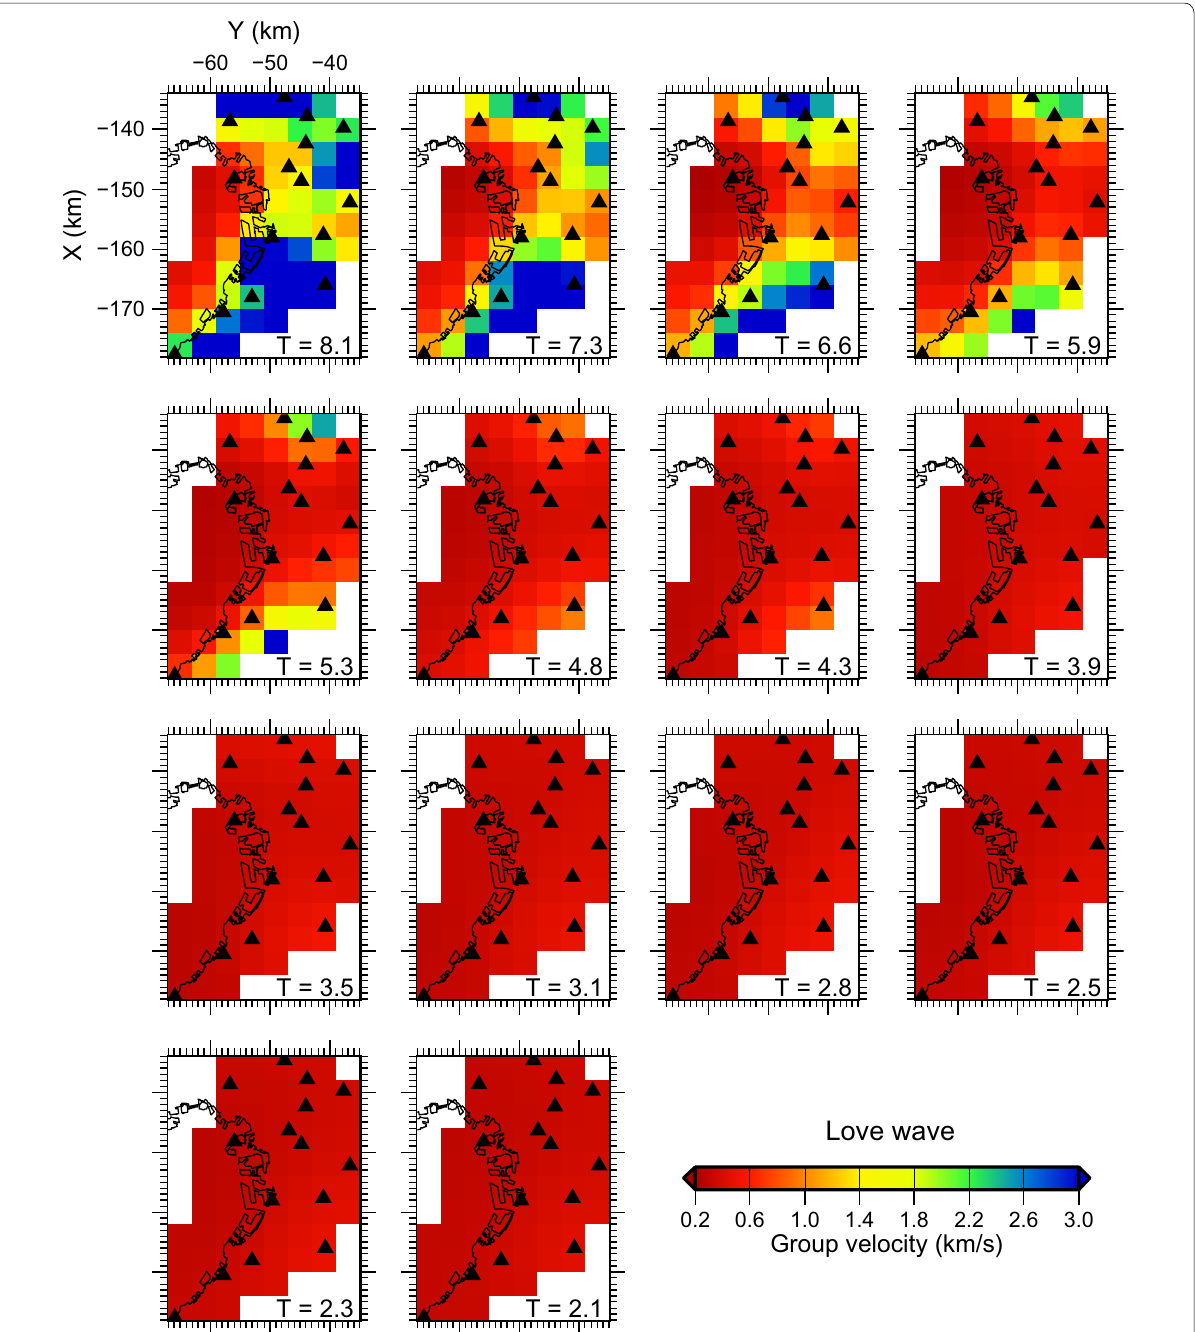
Fig. 10 Maps showing group velocities of Love waves in the period range 2.1–8.1 s estimated from group delay times of inter-station Green’s func- tions. The solid triangles indicate temporary